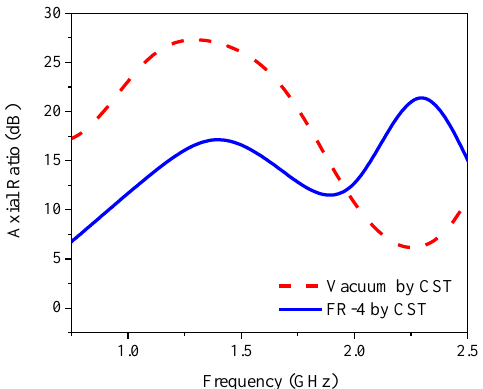
Figure 4. The axial ratio of the inverted L-shaped planar monopole antenna on a partial ground plane in vacuum and with FR-4 substrate.